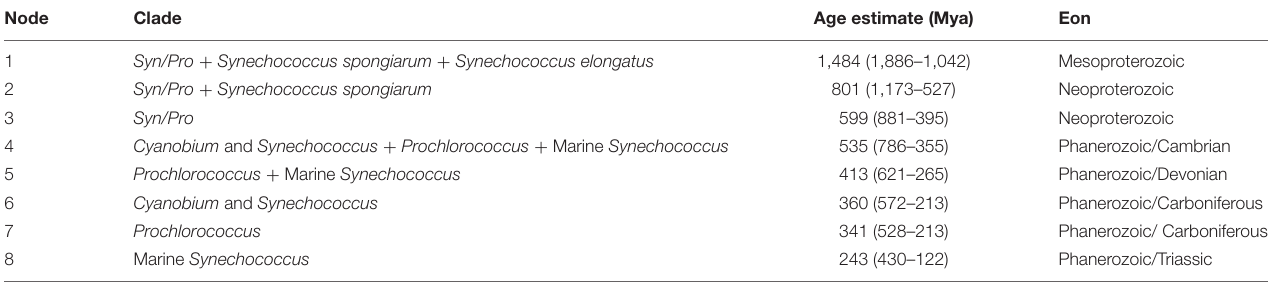
TABLE 1 | Posterior age estimates in Myr using a Bayesian